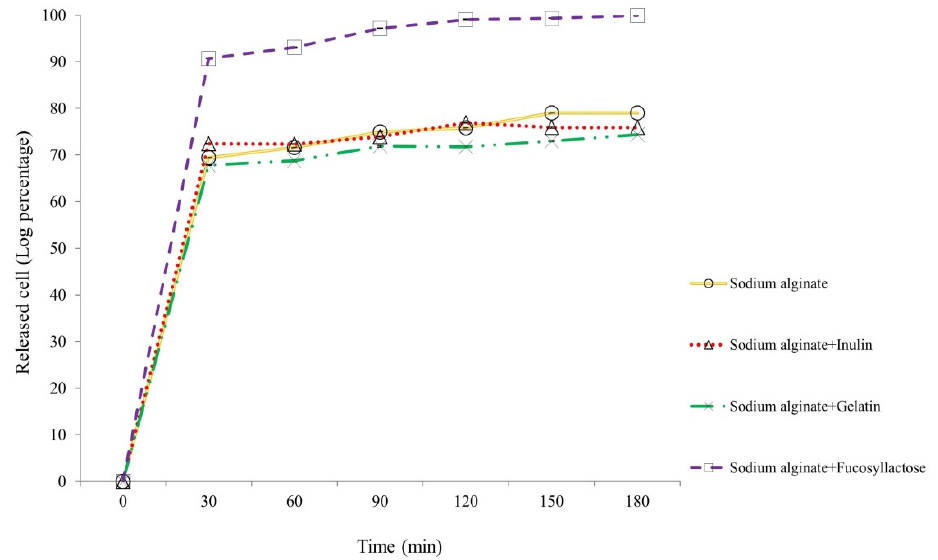
Figure 4. Release kinetics of entrapped S. thermophilus TH982 cells from different capsule formulations during incubation in a simulated intestinal environment.